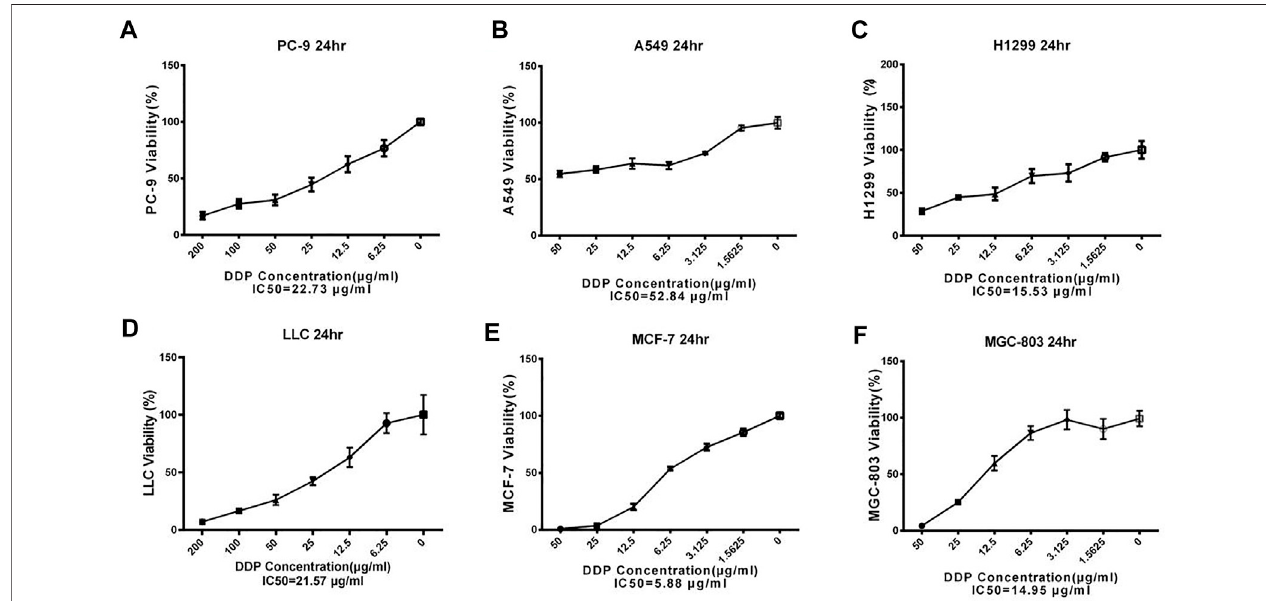
FIGURE 1 | The IC50 of DDP on different cancer cells. Error bars are represented as mean ± SEM. Details of experimental procedures are given in Materials and Methods .